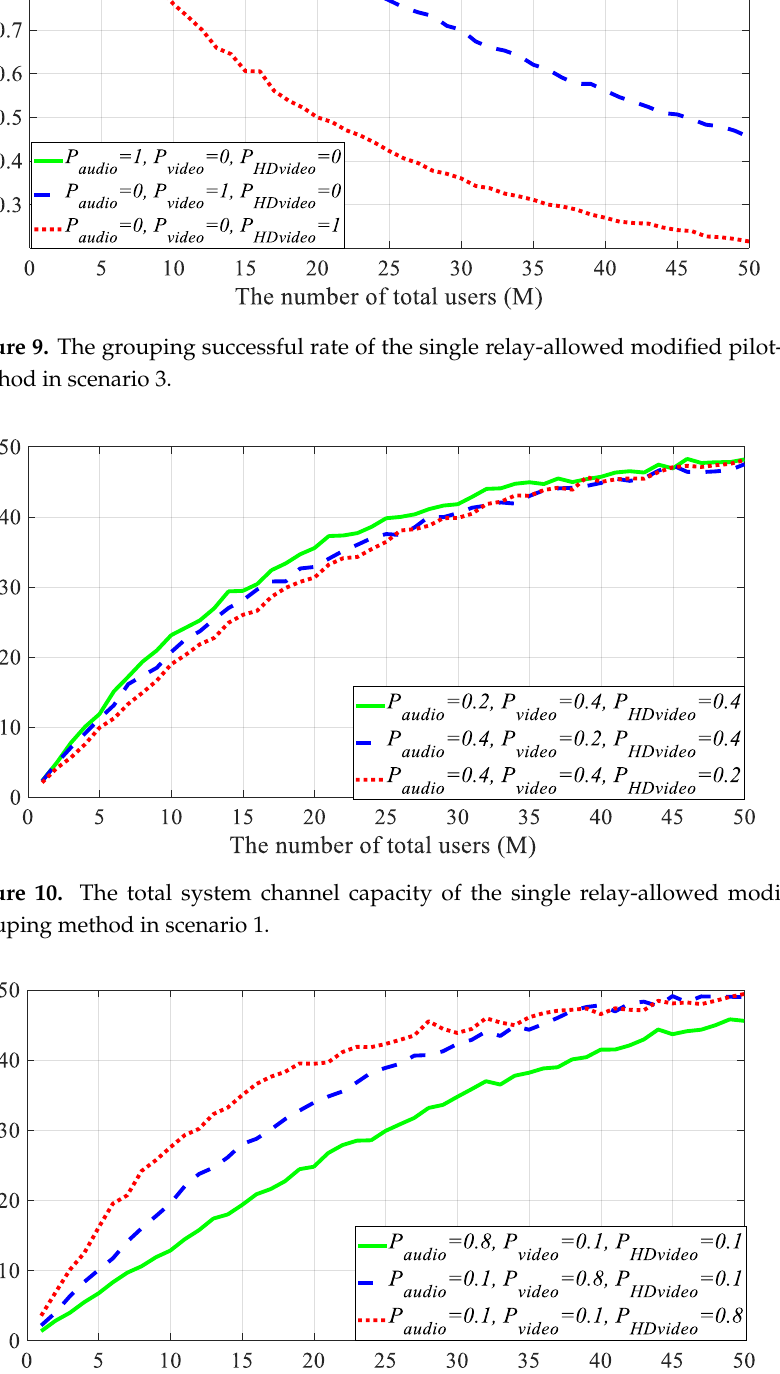
Figure 11. The total system channel capacity of the single relay-allowed modified pilot-based grouping method in scenario 2.